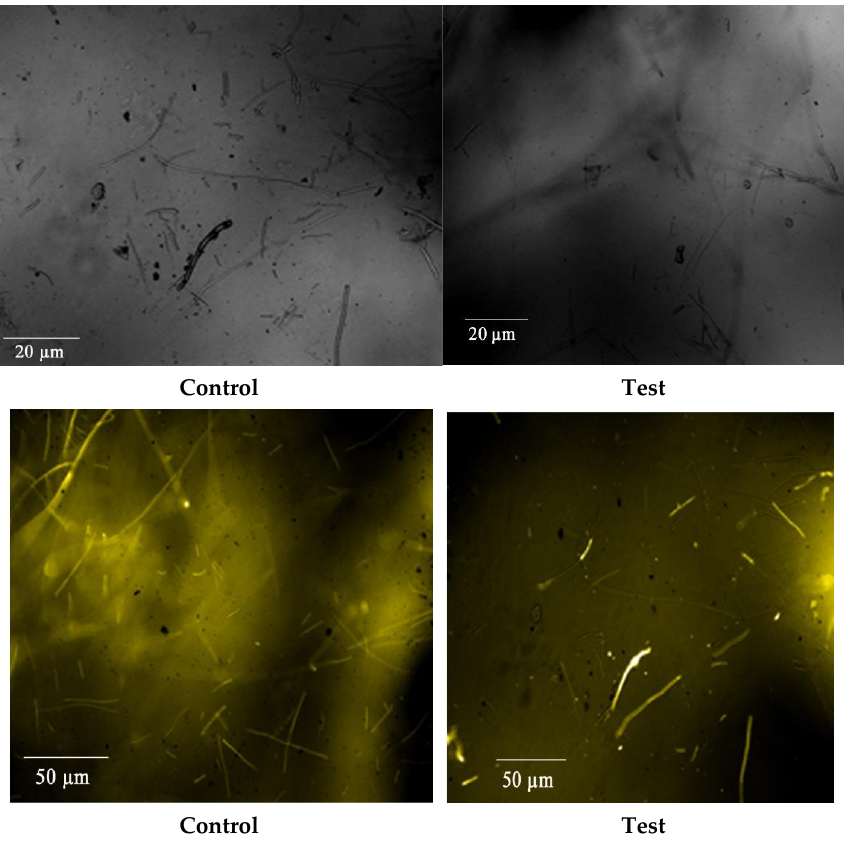
Figure 11. High-content screening images showing the presence of the mycelia in the control slide and treatment slide, where Bs-AgNPs resulted in the destruction of the cell wall and mycelia of R. solani.